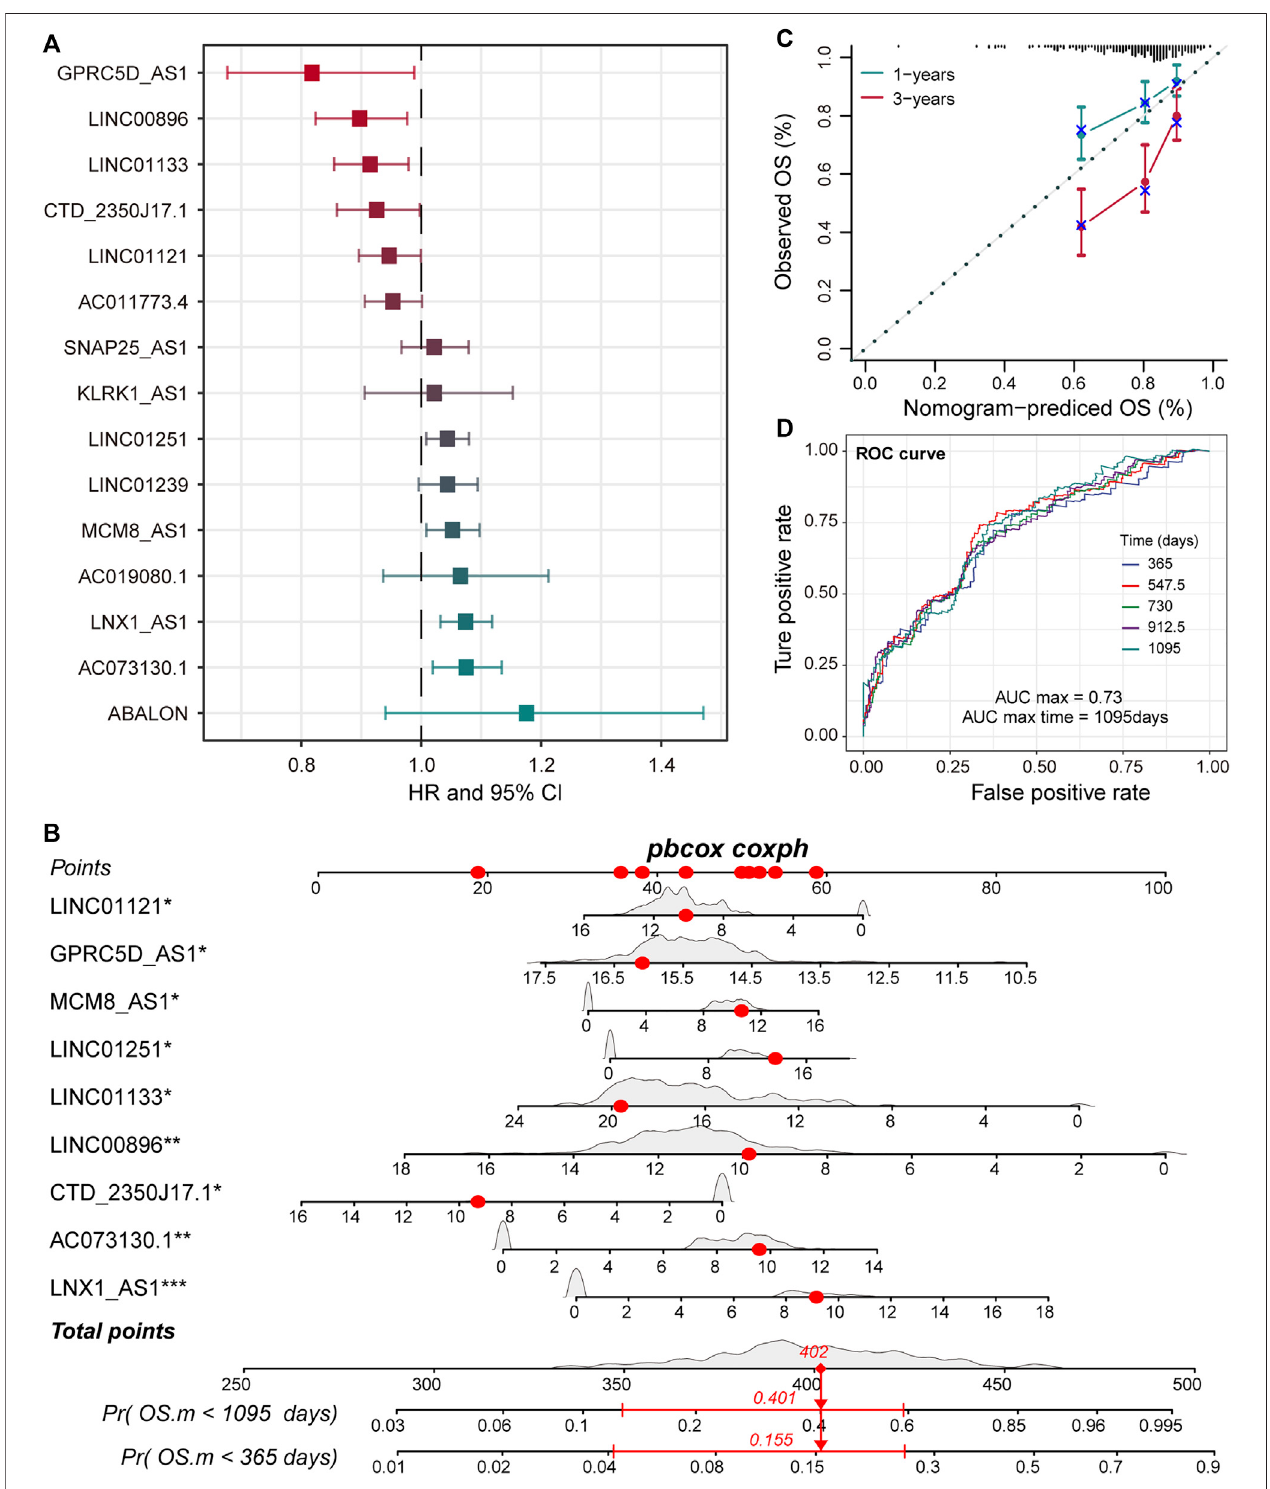
FIGURE 2 | Identi fi cation of prognostic markers for LUSC. (A) The error bar graphs are used to show the correlation between the expression level of lncRNA and thepatient ’ soverallsurvival(OS).Theabscissarepresentsthehazardratio(HR)valuewiththe95%con fi denceinterval. (B) Nomogramforsurvivalriskpredictionof1and 3 years.Thenineprognosticmarkersaremarkedbyastar.Additionally,* p < 0.05,** p < 0.01,*** p < 0.001. (C) Thecalibrationcurveofthenomogram. (D) Thepredictive performance of the survival predictive model at fi ve time points from 1 to 3 years. The different colored curves represent speci fi c time points.